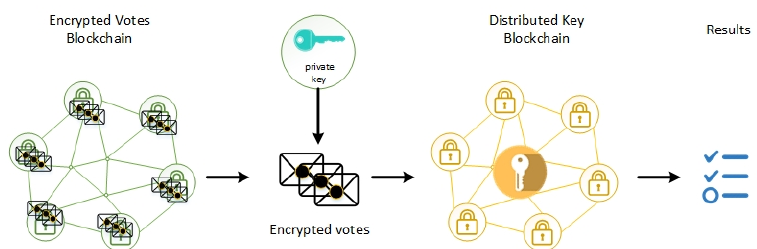
Figure 6. Vote transfer, decryption, and results.